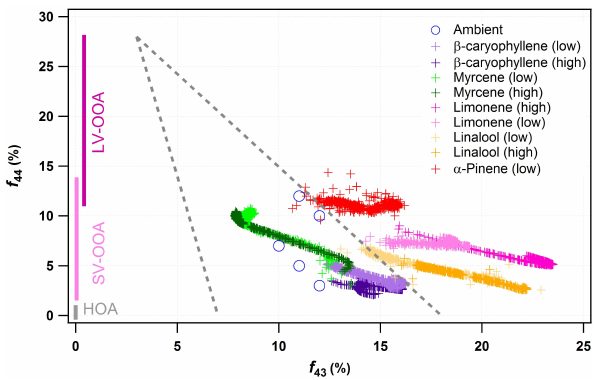
Fig. 4. A 2-dimensional representation of f 44 and f 43 for all SOA systems in this study. The dashed line represents the boundaries of this relationship based on previously published ambient data sets by Ng et al. (2010). The open circles are measurements conducted at biogenically-influenced locations in North America and Europe, as compiled by Ng et al.